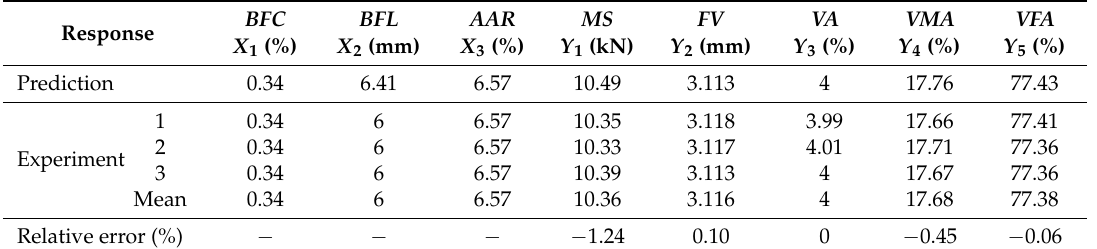
Table 9. Optimal preparation parameters and prediction vs.